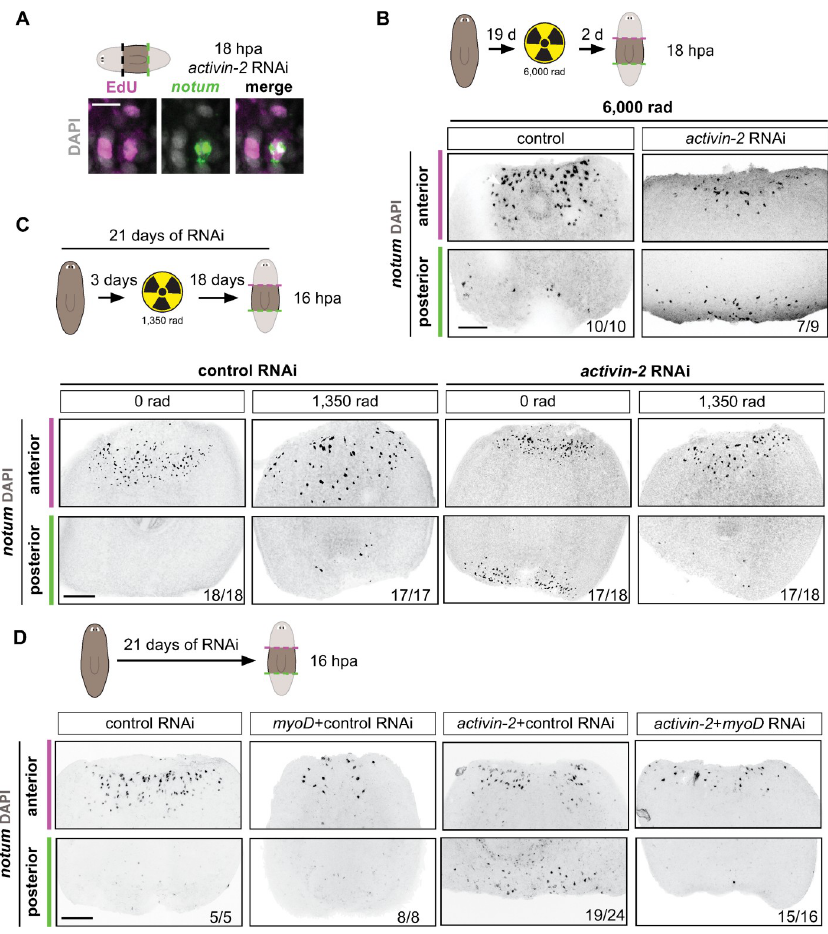
Fig 5. activin-2 promotes the polarized response of newly specified longitudinal muscle fibers to wound orientation. (A) EdU incorporation in notum+ cells at posterior-facing wounds in an activin-2 RNAi animal. Lower magnification in S5A. (B) Top: cartoon shows the experimental design. Bottom: FISH shows notum expression at 18 hours post-amputation 21 days after the first RNAi feeding in lethally irradiated (6,000 rads) animals. (C) Top: cartoon shows the experimental design. Bottom: FISH shows notum expression at 18 hours post-amputation 21 days after the first RNAi feeding where a sublethal dose of irradiation (1,350 rads) was given 19 days prior to amputation. (D) Top: Cartoon showing experimental design. Animals were fed every 3 days. Animals were fed either control or activin-2 dsRNA for feeding 1, 2, 3, 5, and either myoD or control for feeding 4. Bottom: FISH shows notum expression at 18 hours post-amputation 21 days after the first RNAi feeding. Magenta, anterior-facing wounds; green, posterior-facing wounds. All images are anterior up. Scale bars, 200 μ m, except for high magnification panels in where they represent 10 μ